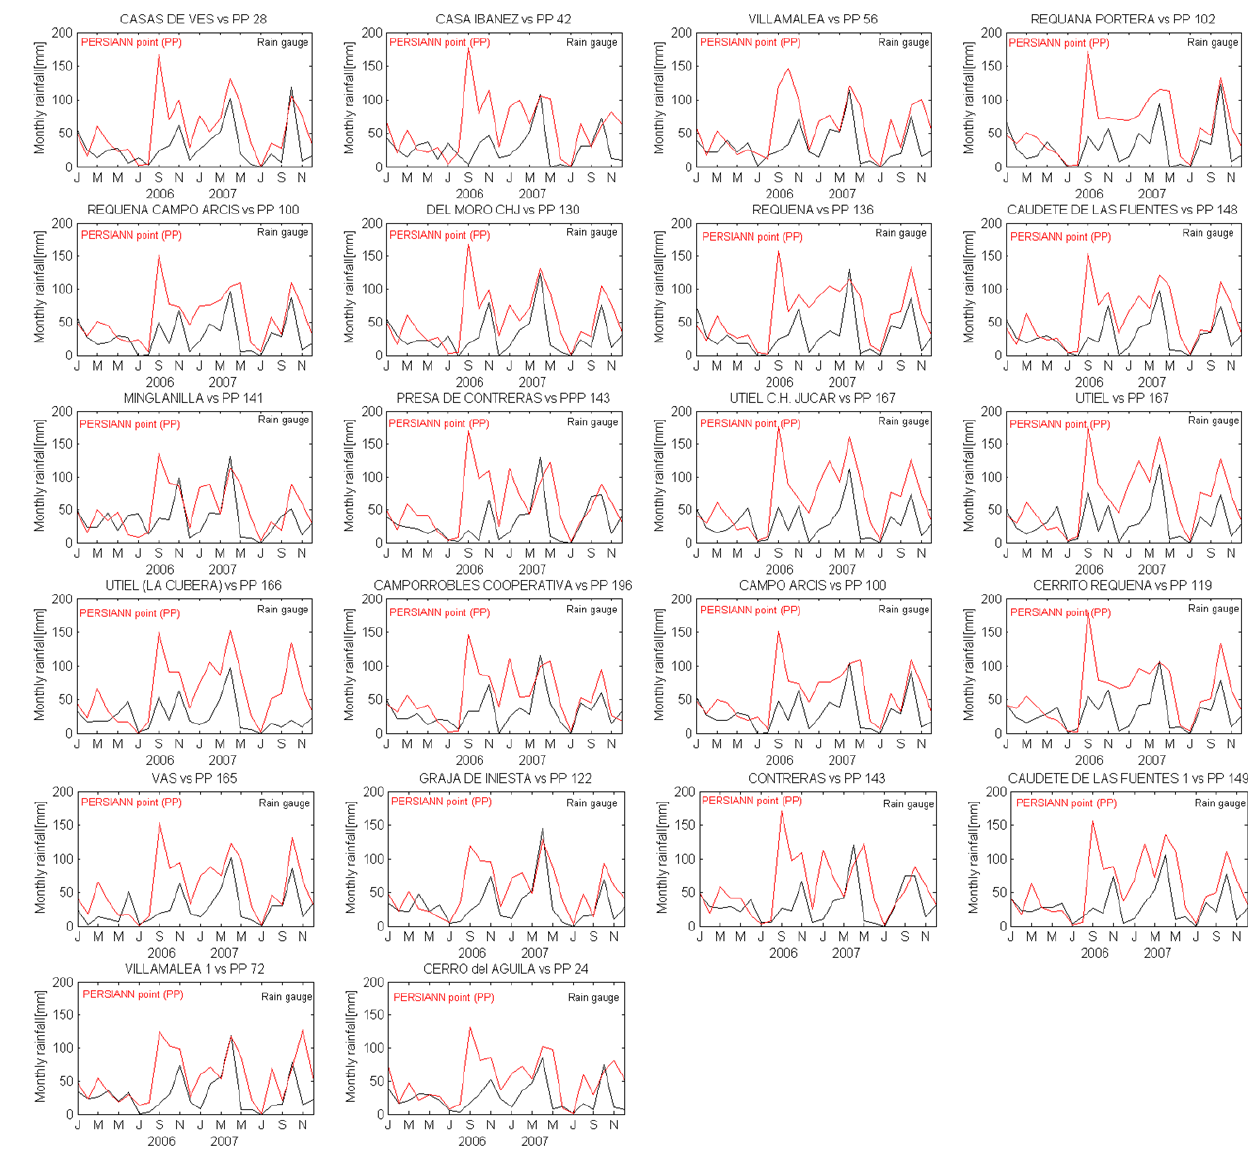
Fig. 2. Monthly comparisons between all the meteorological stations/rain gauges (black line) within the 50 × 50 km 2 VAS area and their nearest PERSIANN points (red lines) for 2006 and 2007.